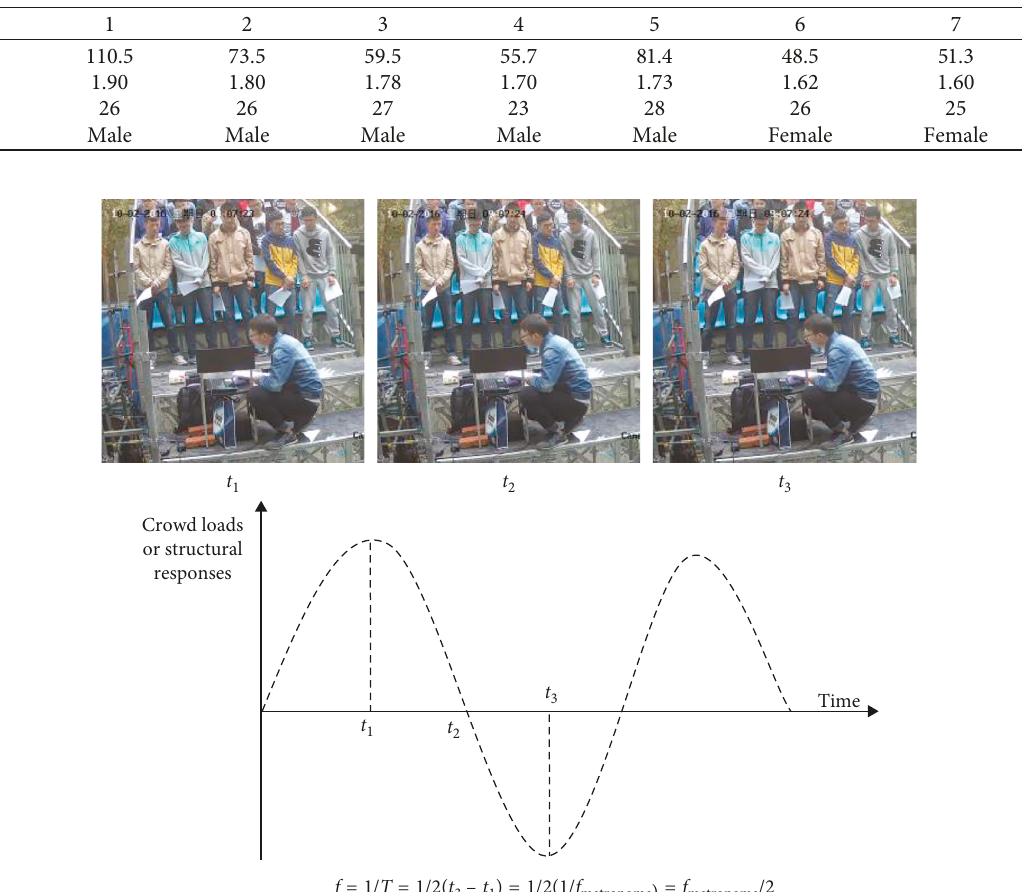
Table 1: Fundamental physics information of participants.